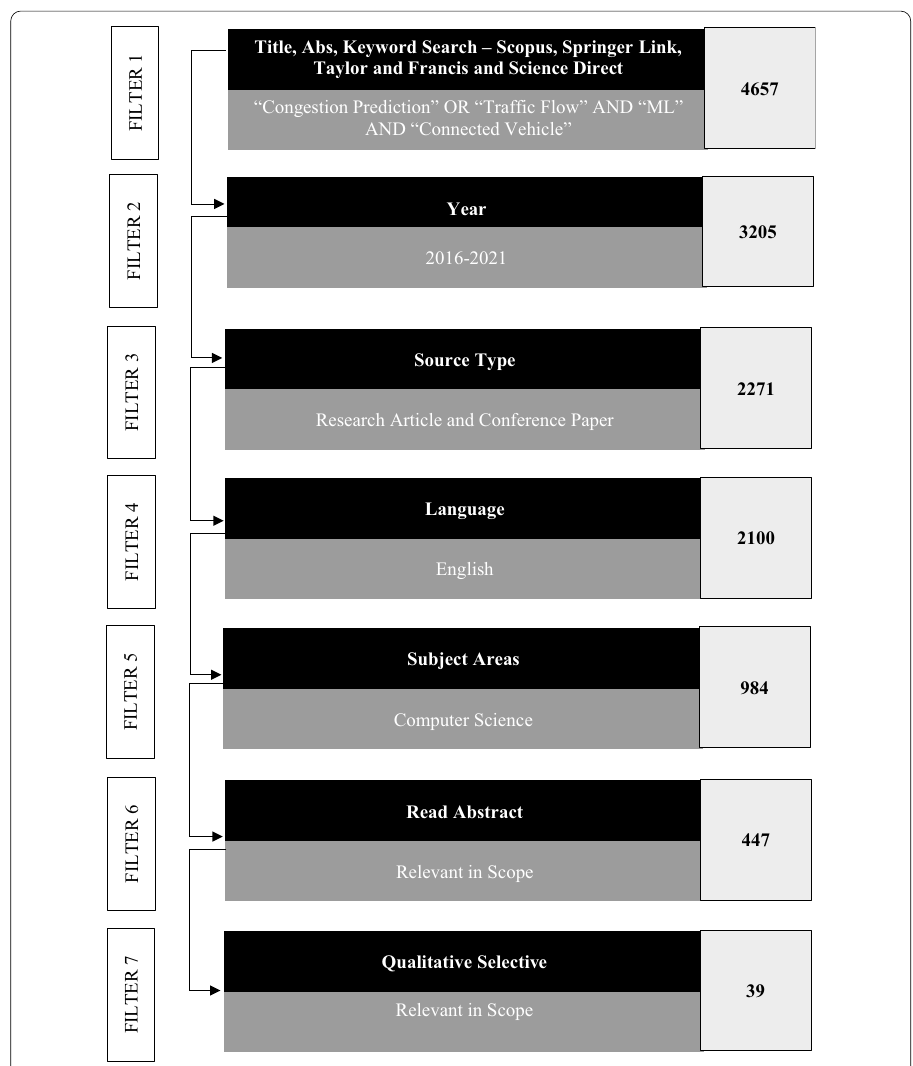
Fig. 4 Sequence of the SLR